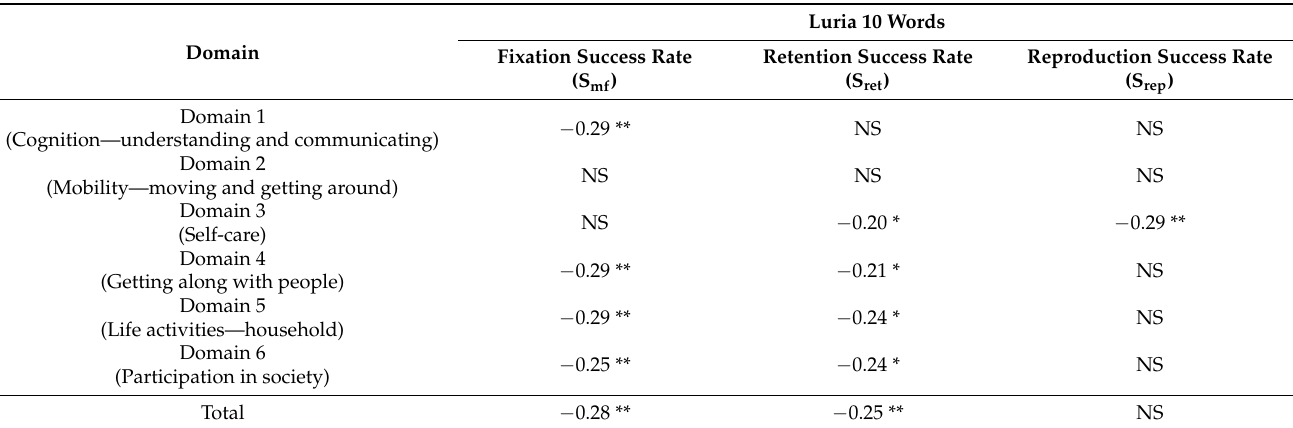
Table 5. Correlation with Luria 10 words.